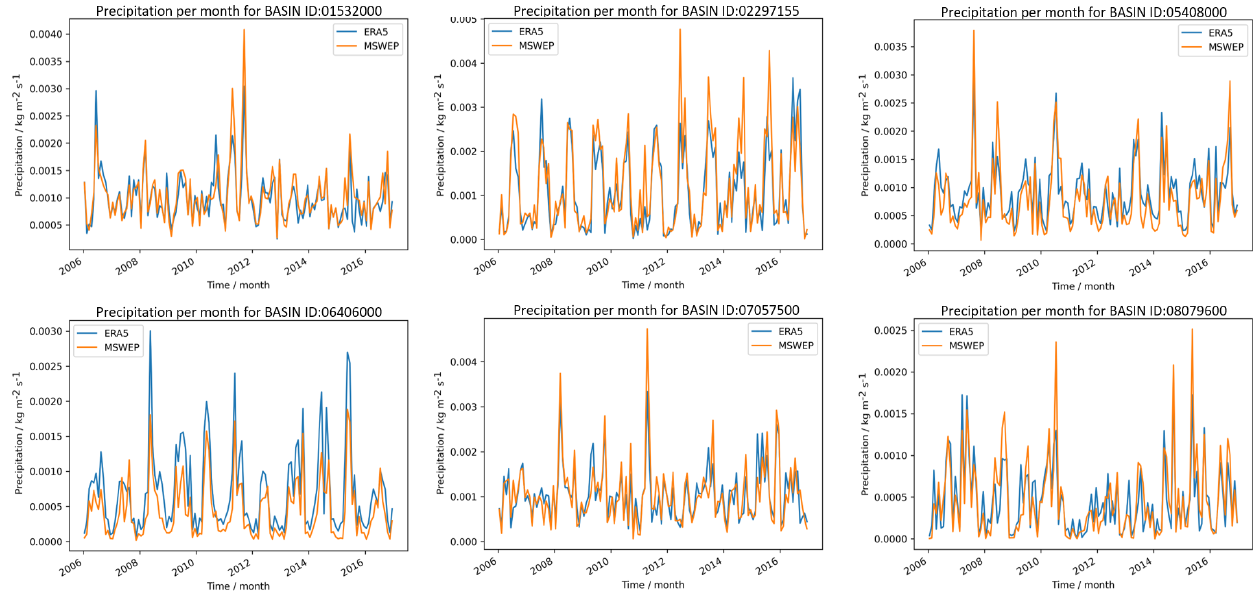
Figure A1. Evaluation period results. ERA5 and MSWEP forcing comparison for six basins in the CAMELS data set. Monthly precipitation values for the evaluation period are shown for ERA5 in blue ERA5 and for MSWEP in orange.